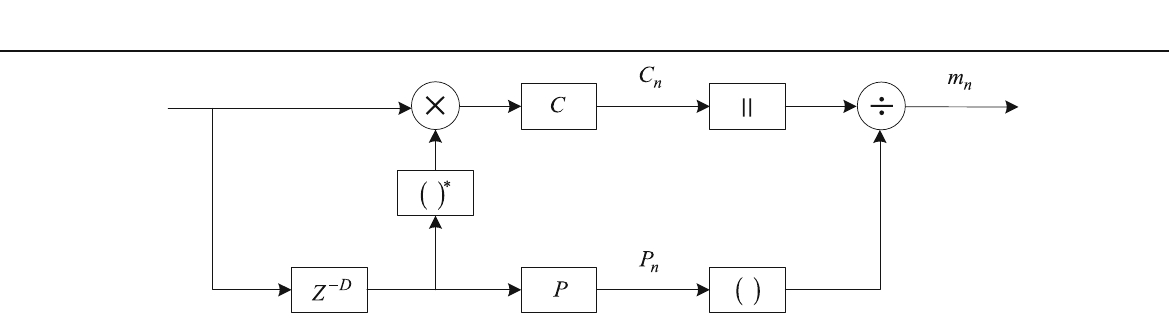
Fig. 3 The structure of AD9361. The whole circuit of RF and IF signals is integrated into one chip by adopting zero-IF architecture, which is composed of the transceiver, the configuration interface of SPI, the AUXADC, the internal PLLs, the programmable GPO, and the data bus